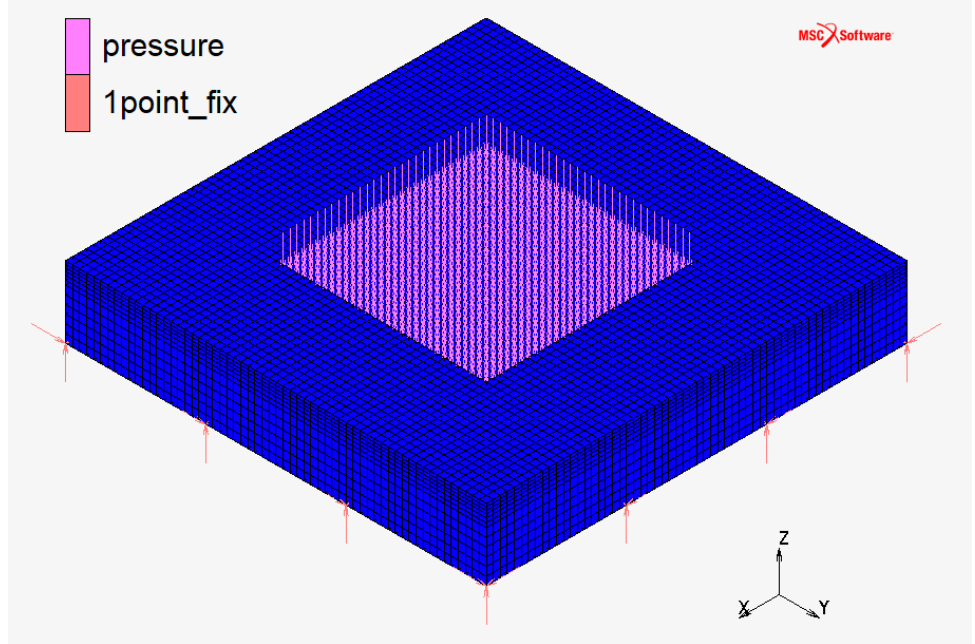
Figure 2. Monopolar plate—discretized domain in configuration “a”: squared plan view and squared active area.